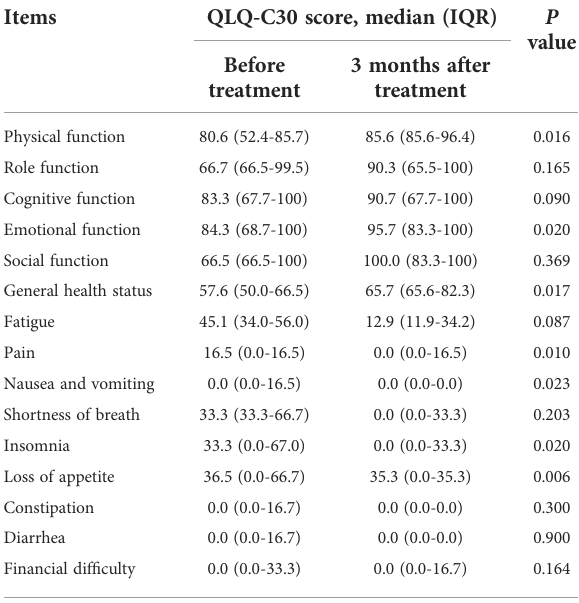
TABLE 3 QLQ-C30 score before and at 3 months after treatment.